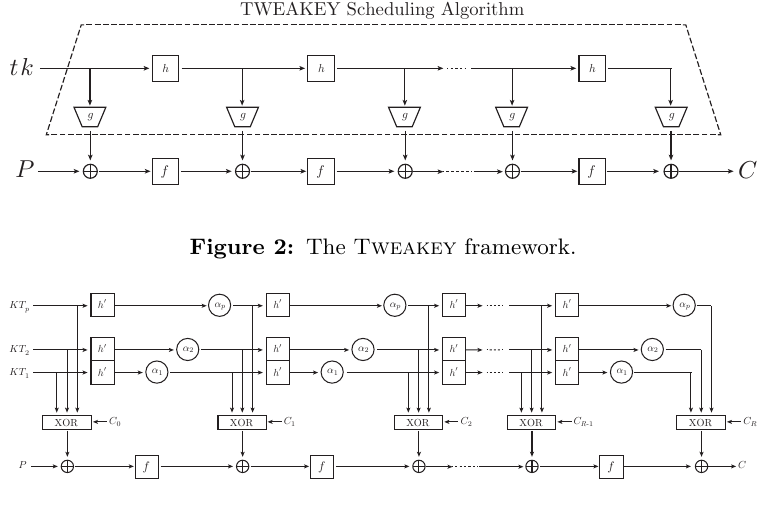
Figure 3: STK construction: Example with TK - p